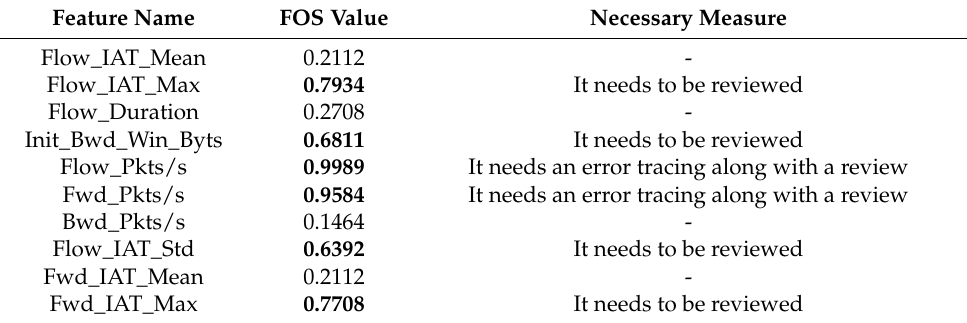
Table 9. Suspicious feature analysis result of the instance. According to the result of calculating the FOS of the instance, suspicious features are selected among the features, and actions to be taken by the analyst are suggested according to the FOS